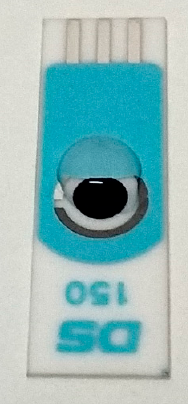
Figure 4. Direct contact between the cell suspension of pAb76-membrane-engineered Vero cells and the screen-printed working electrode.